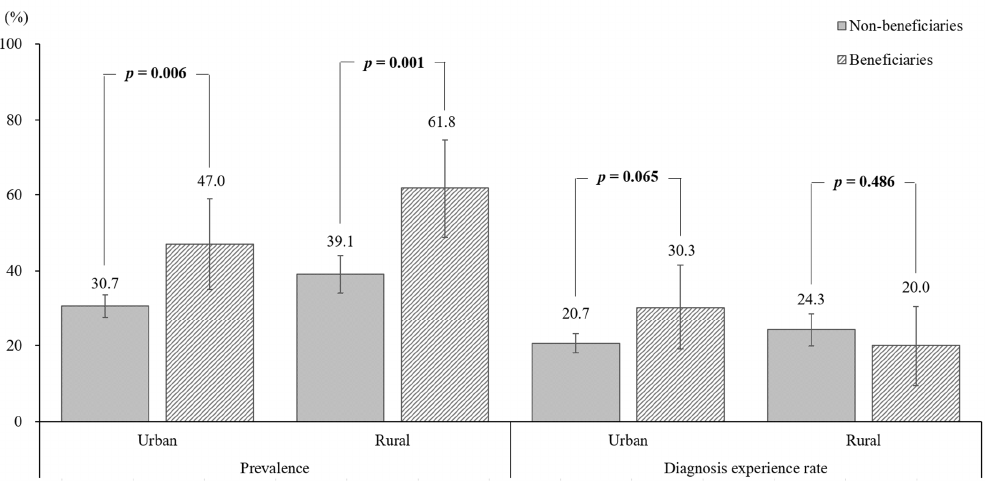
Figure 1. Osteoporosis prevalence and diagnosis experience rates by basic livelihood condition according to the areas of residence. 3.3. Influence of the Factors on the Osteoporosis Prevalence and Diagnosis Rate in the Urban and Rural Areas